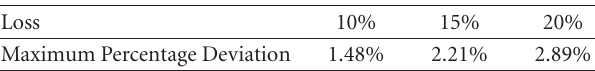
Table 1: Maximum percentage deviation of the predicted value of X -Axis position at client.